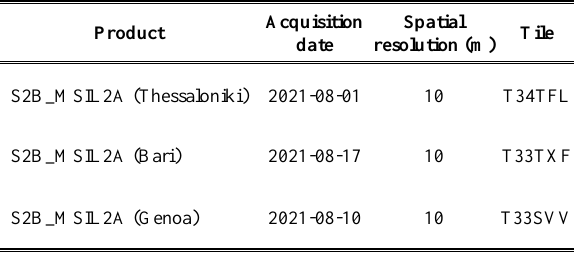
Table 1 . Optical satellite data used.